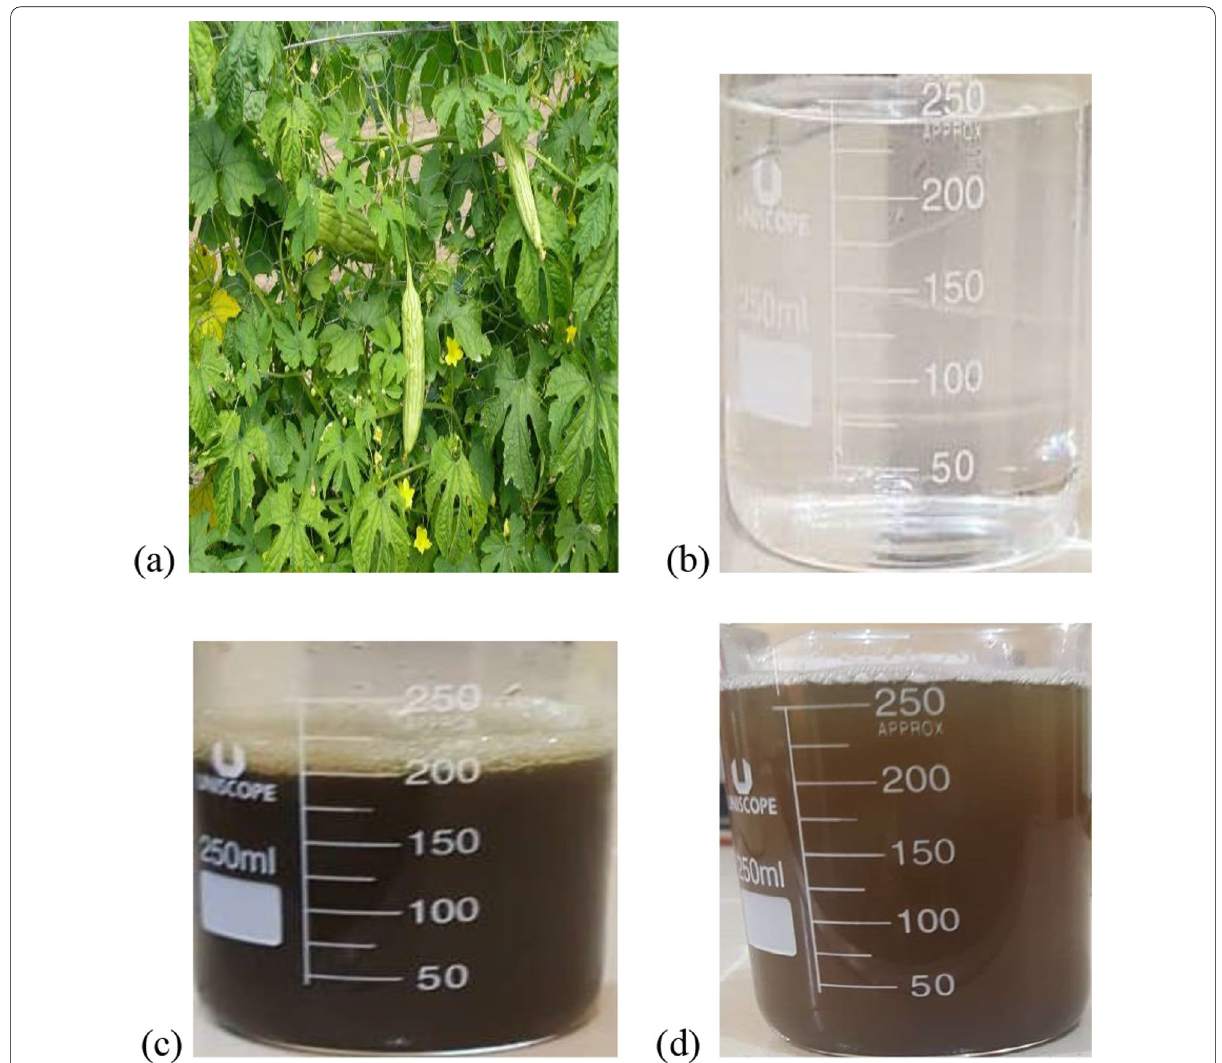
Fig. 1 Green synthesis of M. charantia nanoparticles. Picture of a M. charantia leave b silver nanoparticles ( c ) and d mixture of silver nitrate and bitter melon aqueous solution after 5